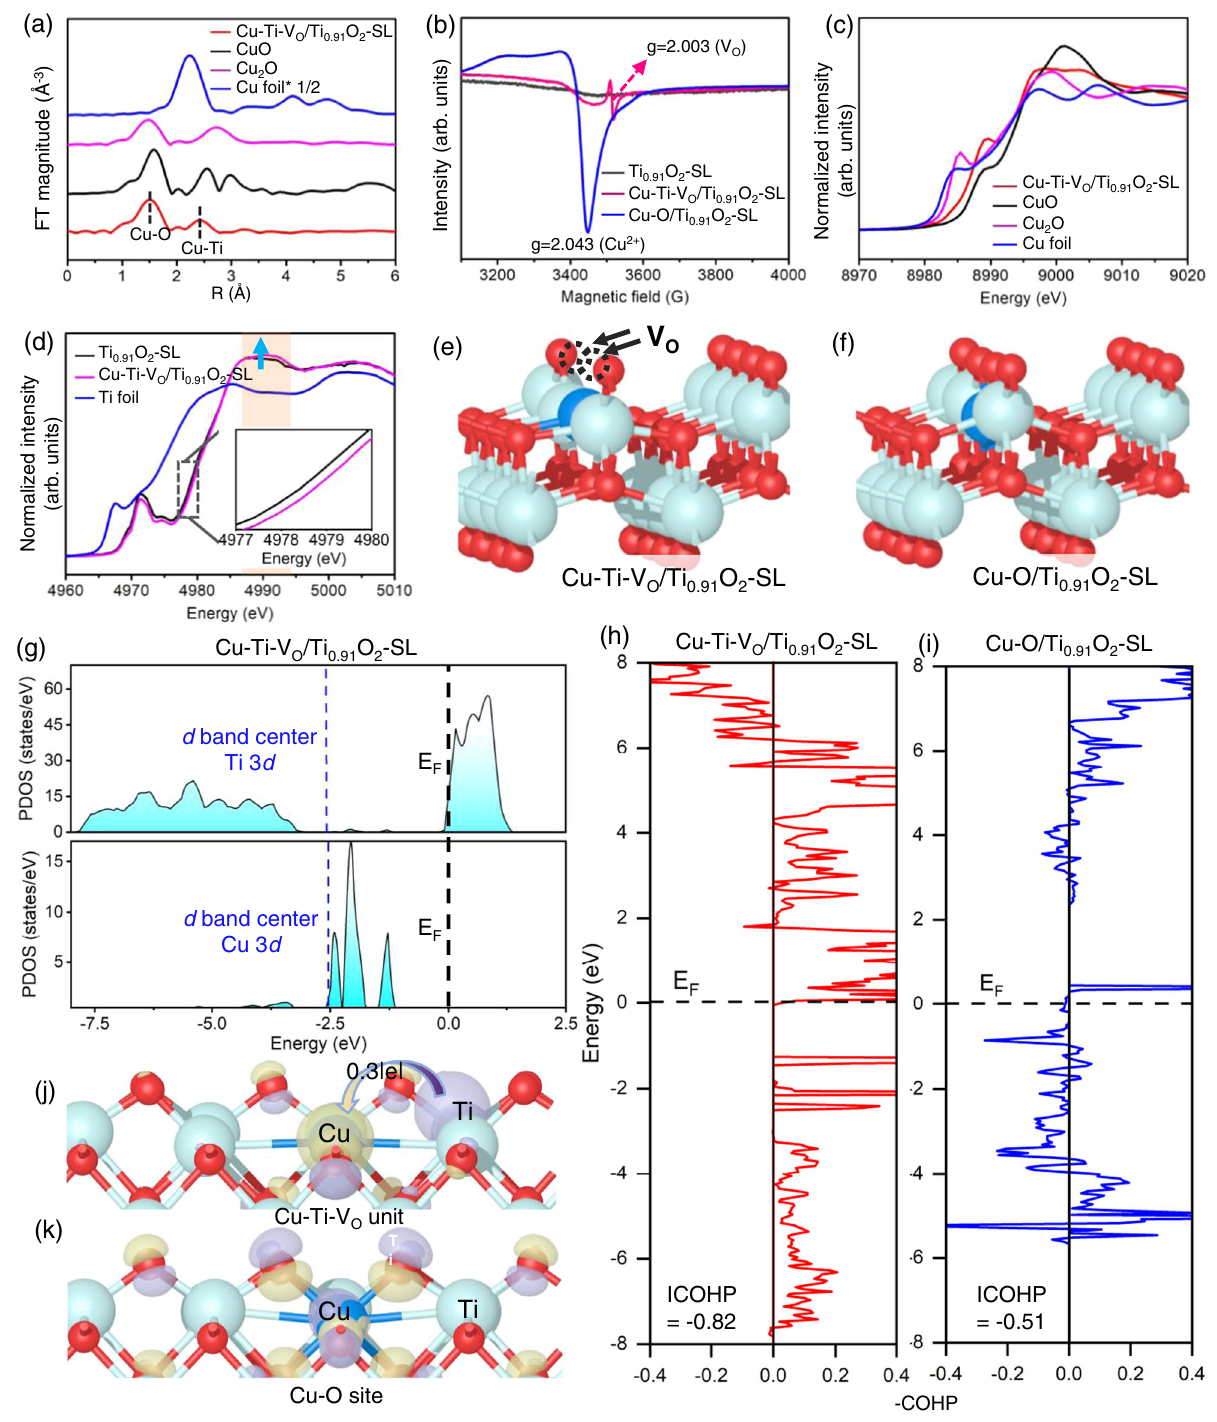
Fig. 2 | Electronic structure of Cu-Ti-V O /Ti 0.91 O 2 -SL. a Fourier transforms of EXAFS spectra at the Cu K-edge. b EPR spectra. Normalized XANES spectra at the c CuK-edgeand d TiK-edge. e , f Theatomicstructurecon fi guration(colourcodes: